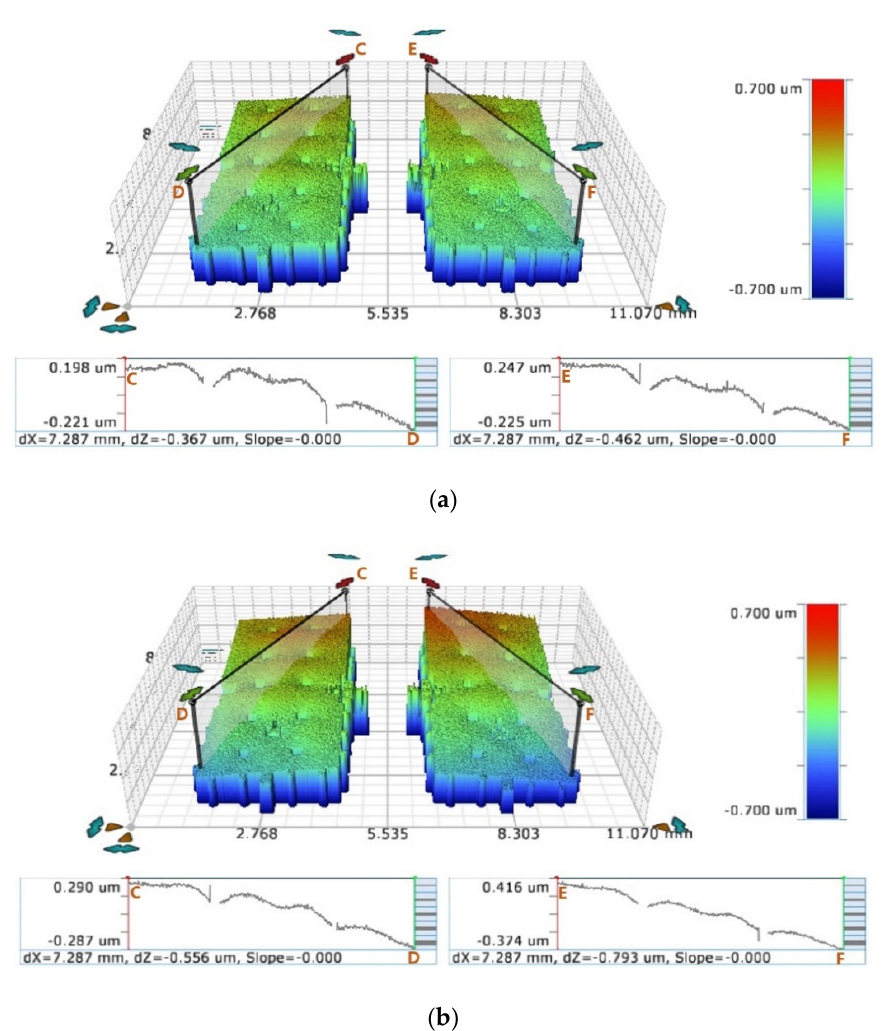
Figure 8. Deformation of proof masses in Type I-B device: ( a ) before packaging and ( b ) after packaging.